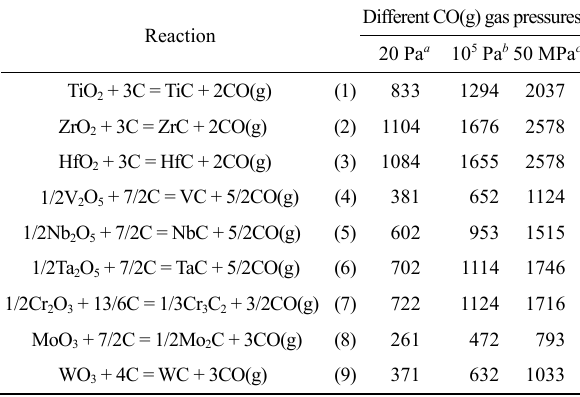
Table 2 T s (when  G = 0) for carbothermal reduction reactions under different CO(g) gas pressures (Unit: ℃ )